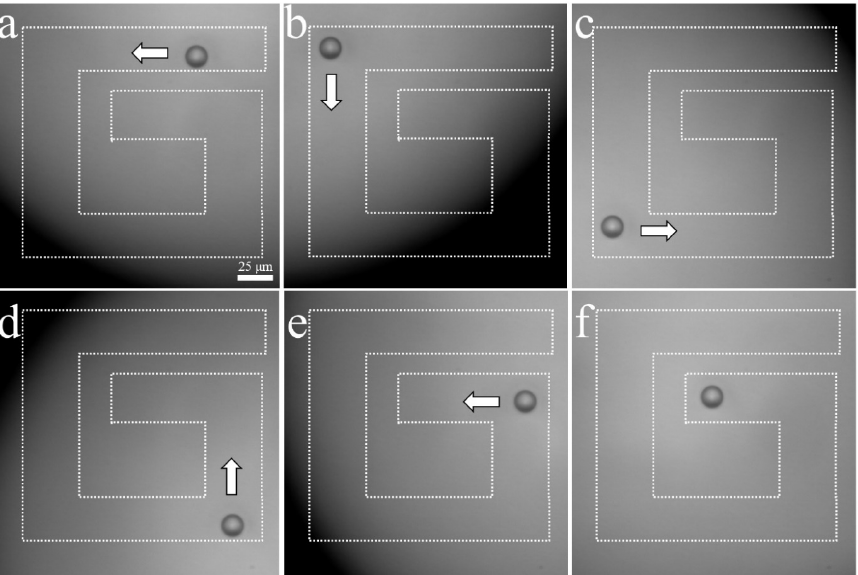
Figure 10. Microscopic photographs of a 15 μ m polystyrene bead manipulation using a 410 MHz transducer: ( a – f ) show the movement of a bead along the SBAT direction. The white arrow represents the direction of transducer movements. A bead is moved through a “G” pattern. Scale bars indicate 25 μ m.